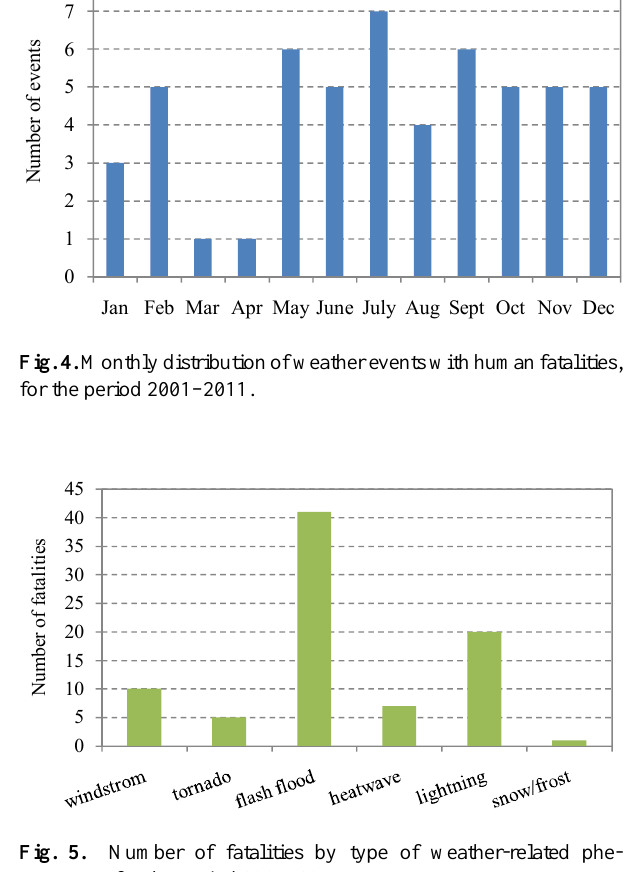
Fig. 7. Distribution (%) of the total number of weather-related phe- nomena by type